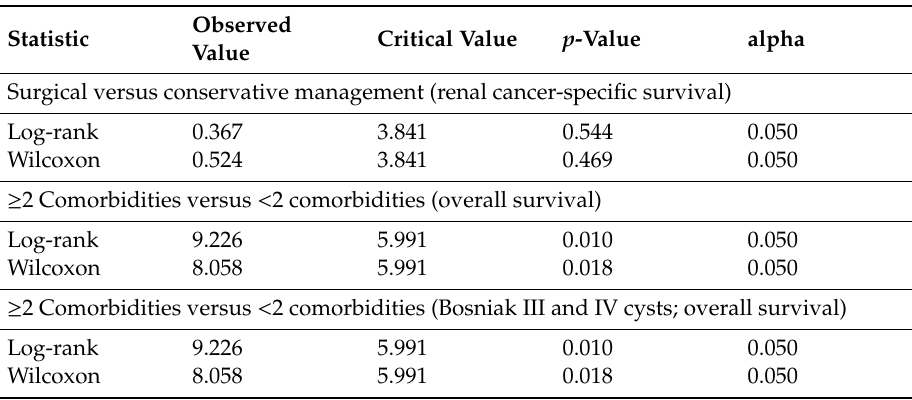
Table A1. Kaplan-Meier analysis, comparison of survival.